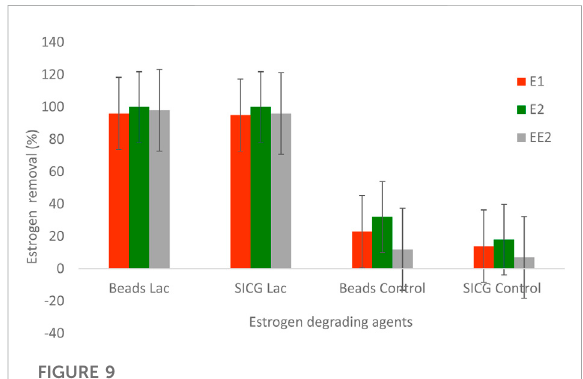
FIGURE 9 Removal of EDCs in a lab-scale continuous fed batch bioreactor using immobilized